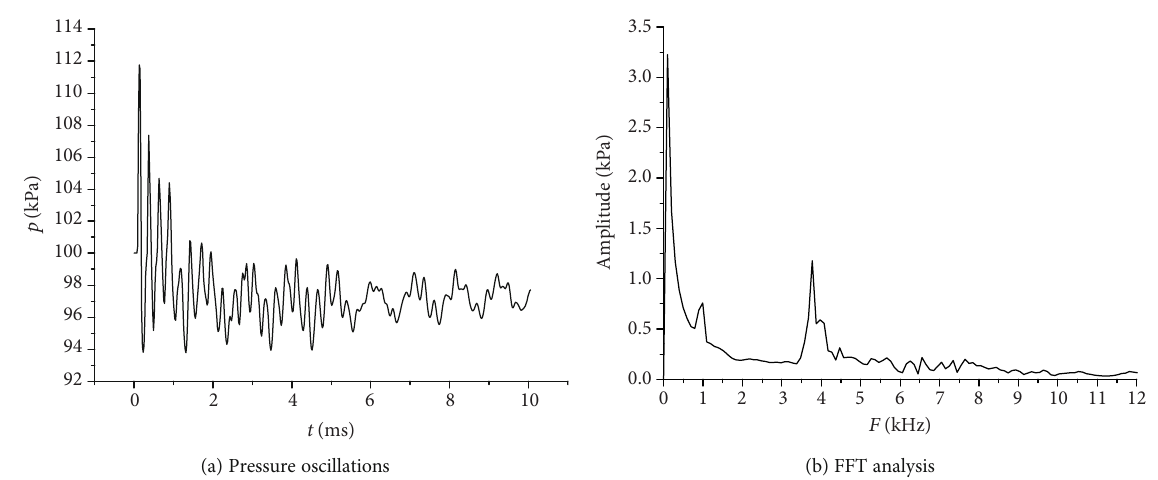
Figure 5: Pressure oscillations and their FFT analysis at the observation point for Model A chamber. Table 3: Eigenfrequency, power amplitude, and damping rate of acoustic modes in the Model A